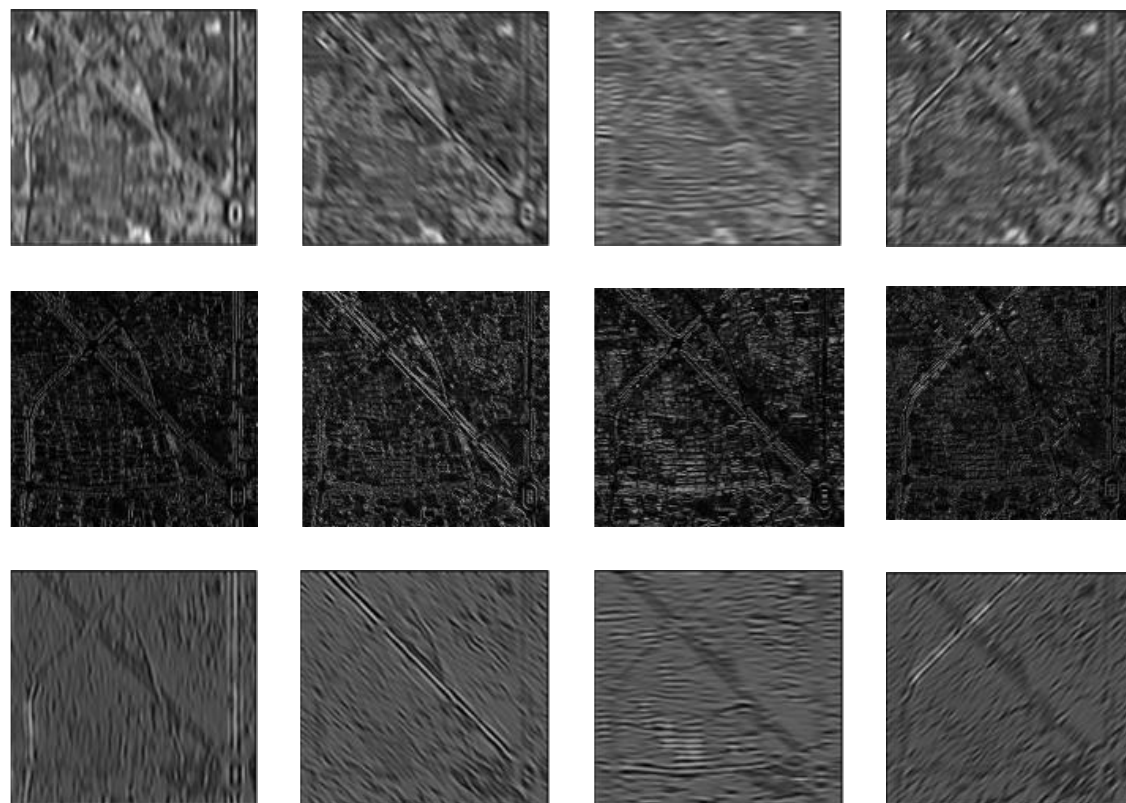
Figure 2. Features detected by Gabor filters(the top are the low frequency features, the middle are the high frequency features,